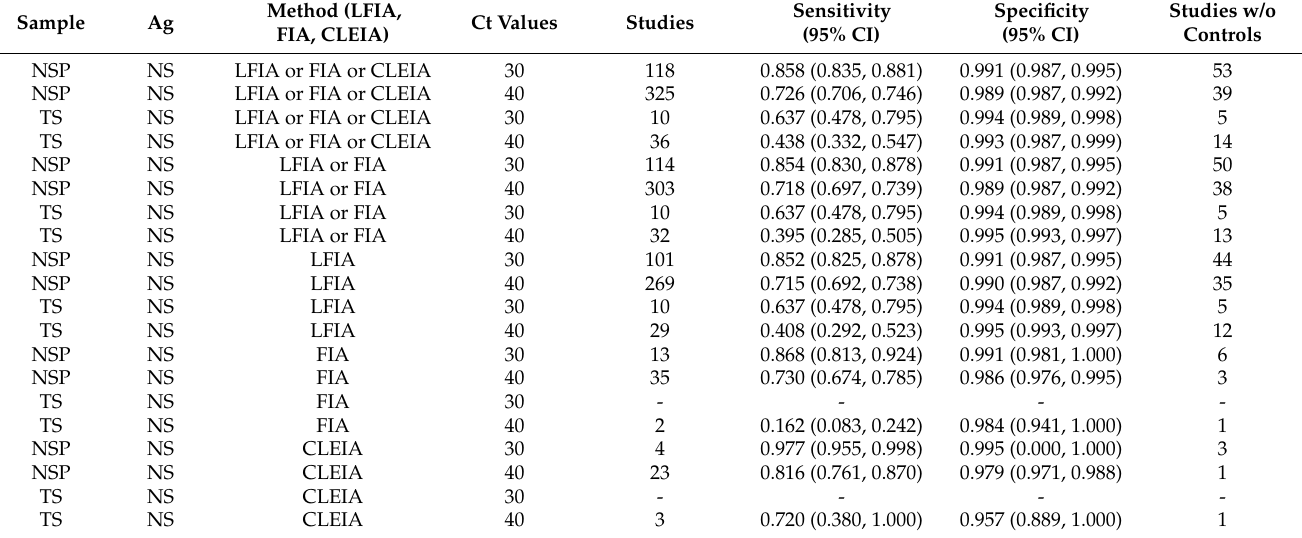
Table 3. Results of the multivariate meta-analysis performed cumulatively for methods and/or anti- gen tested, in <30 and <40 Ct values. Listed information includes the pooled sensitivity and specificity along with the 95% confidence intervals (NSP: pharyngeal, nasopharyngeal, nasal specimens, TS: throat, saliva, oropharyngeal, N: nucleocapsid protein, S: spike protein, M: membrane E: envelope, NS: nucleocapsid and Spike